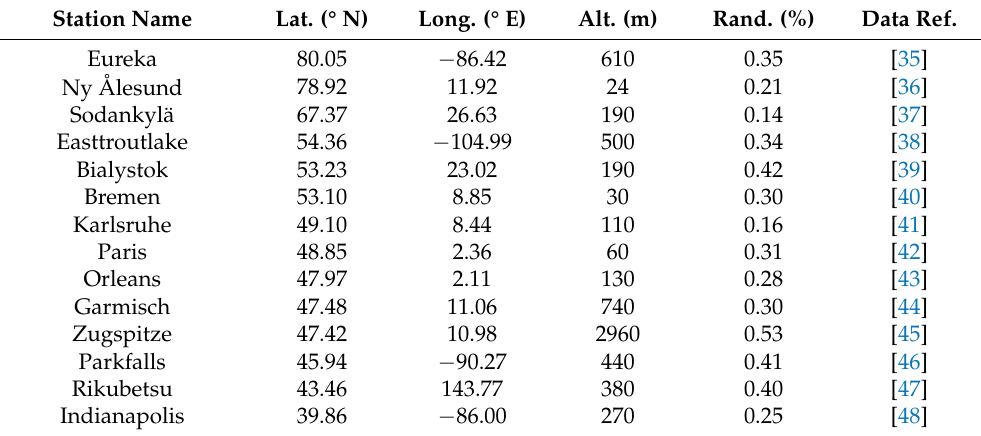
Table 3. List of TCCON stations providing N 2 O, with the reported mean N 2 O random uncertainties (to which 1% should be added, see text) and the data